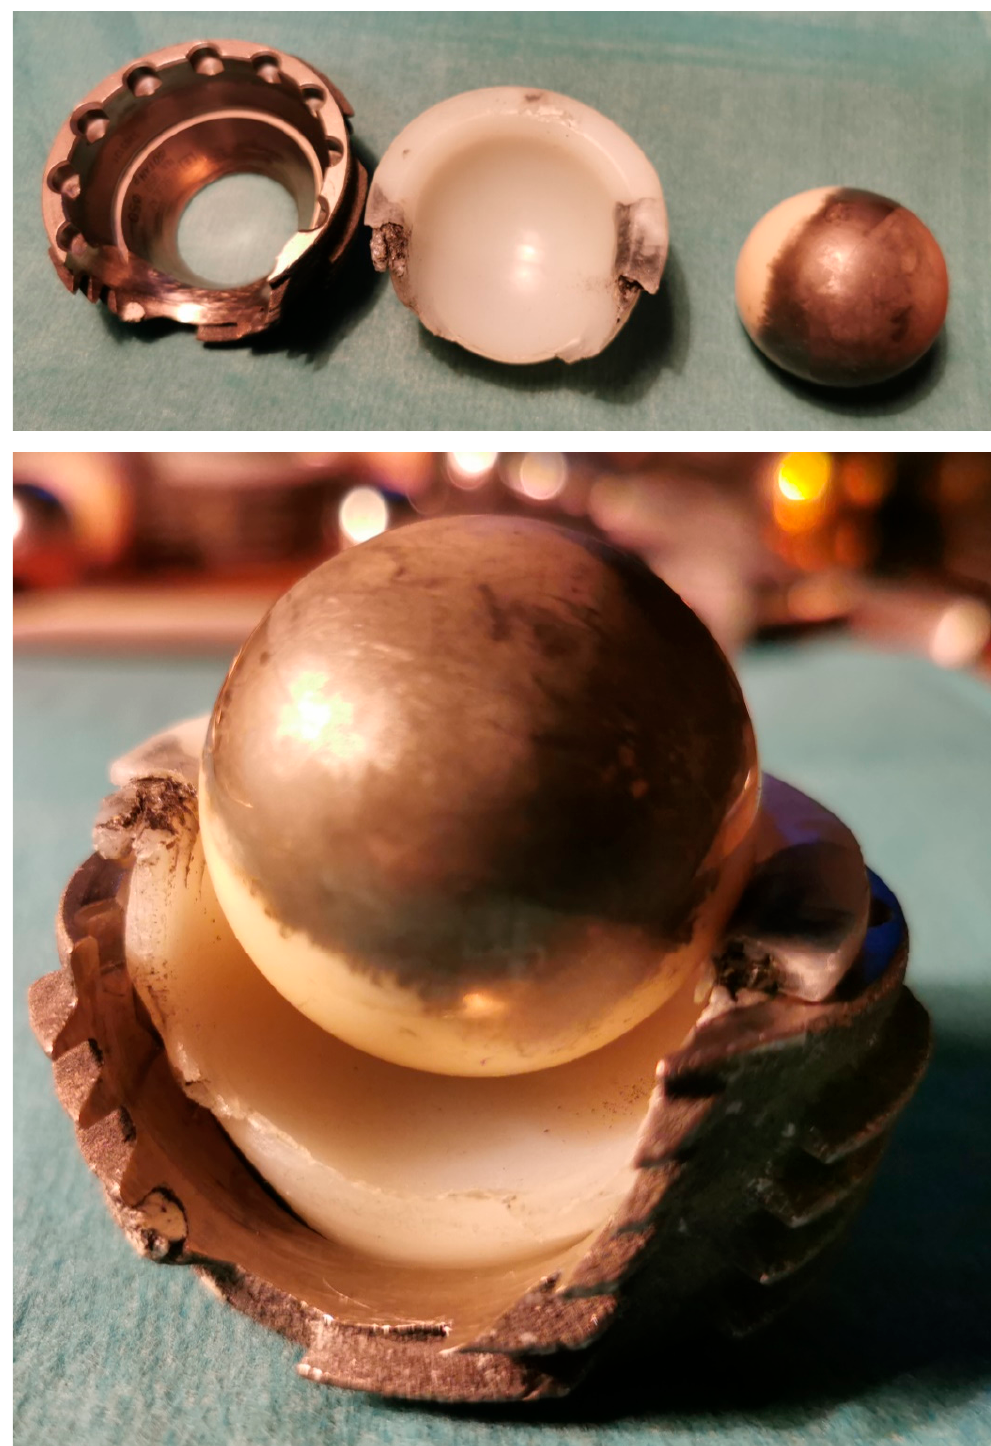
Figure 5. An example of the acetabular cup grinding and its UHMWPE insert by Al 2 O 3 ceramic head during decades-long weight bearing.